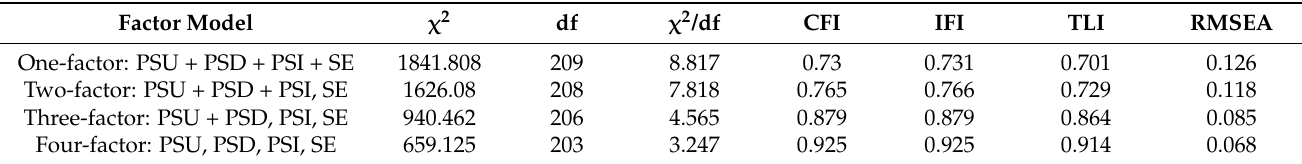
Table 3. Test for discriminant validity.